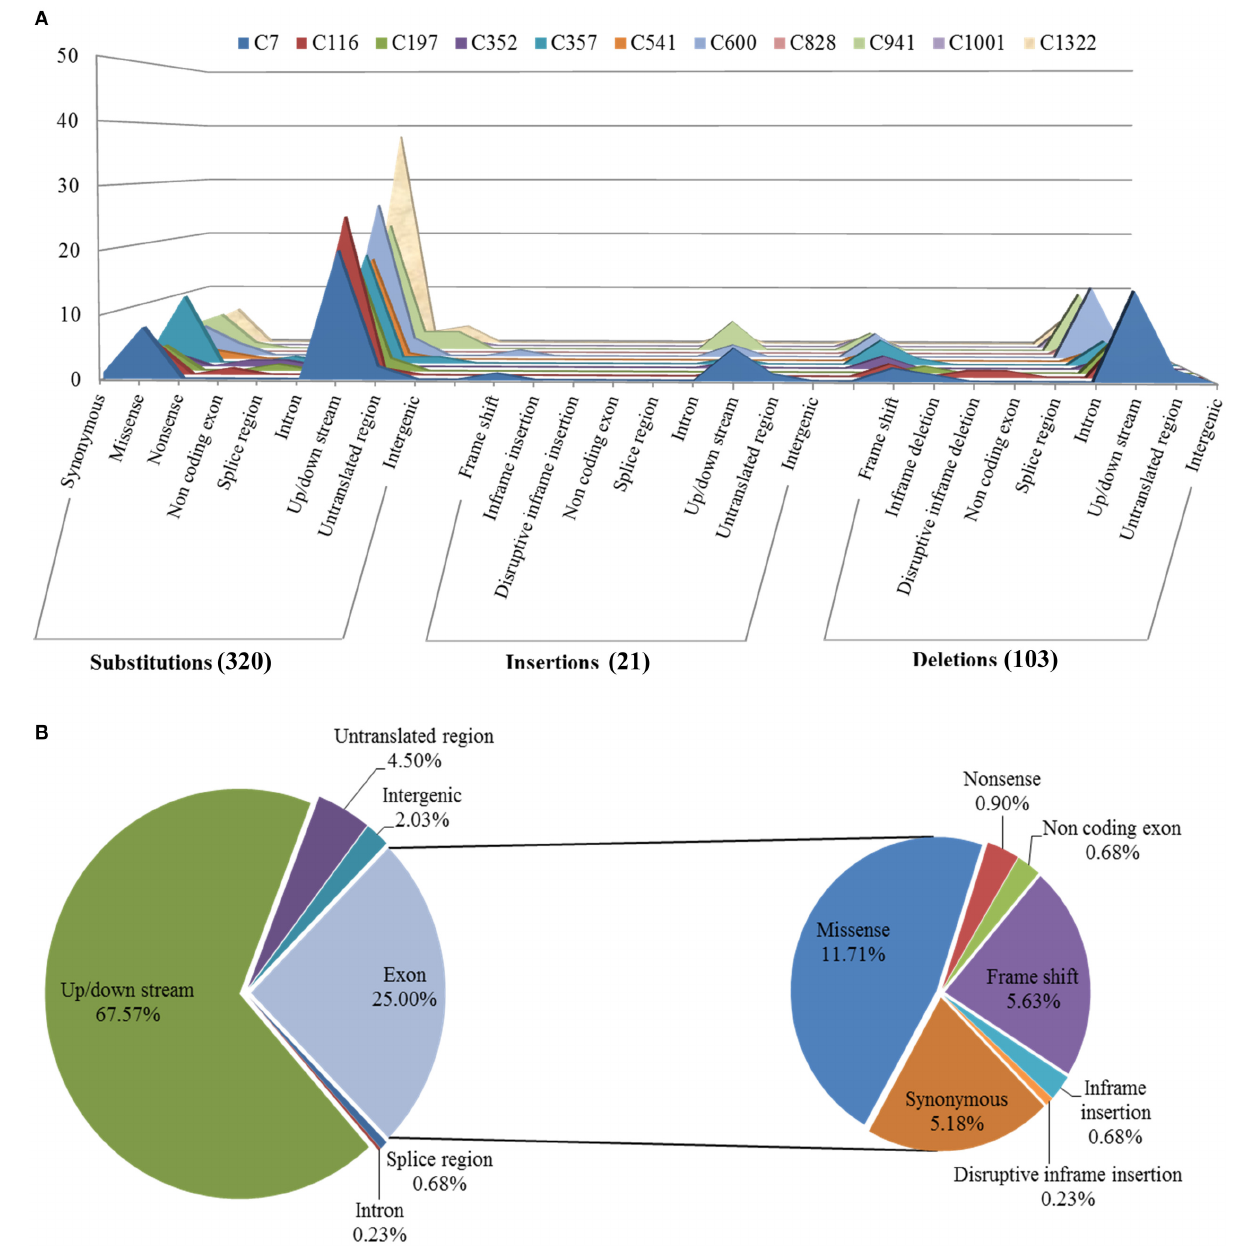
FIGURE 5 | Annotation of mutations induced by CIB irradiation in genomes of 11 mutagenesis progeny lines (M3) of Arabidopsis thaliana . (A) Mutations comprehensively inferred by BWA, SAMtools, VarScan 2, as well as their distributions among functional classes and mutation effects in each CIB-irradiated M3 plant line. (B) Overall distribution of mutations induced by CIB irradiation at the whole genomic level in Arabidopsis thaliana .